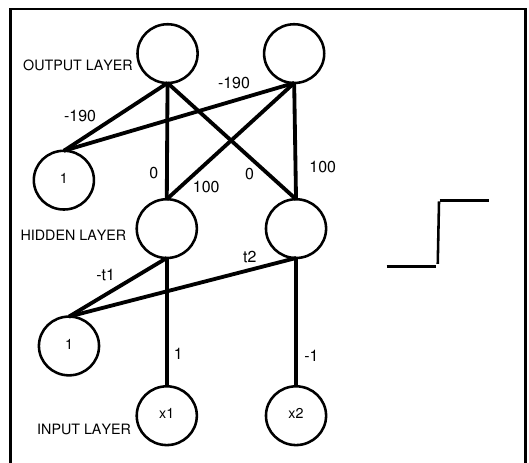
Figure 4. An interpretable MLP coding a propositional rule with two antecedents, ( x 1 > t 1 ) AND ( x ≤ t ) 2 2